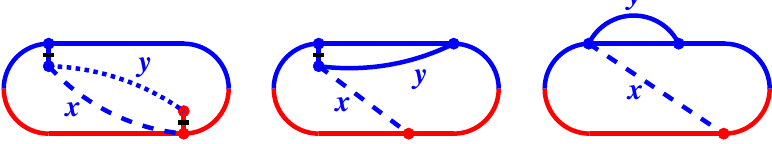
1 x in the results ! (cid:0)